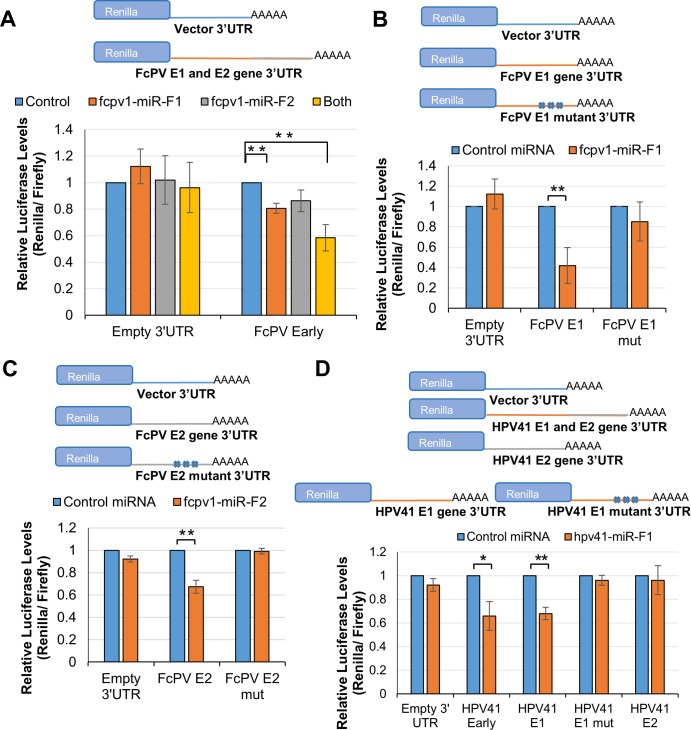
PV-encoded miRNAs can regulate transcript sequences in early genes.RISC reporter assays for the PV-encoded miRNAs. In all panels, the average Renilla luciferase activity normalized to firefly luciferase activity is shown, error bars indicate Standard Error, and asterisks indicate statistical significance, (*) p≤0.05; (**) p≤0.01. (A) HEK293T cells were co-transfected with either a control empty miRNA expression vector (control) or the indicated PV miRNA expression vector along with both the normalization control firefly luciferase vector and a Renilla luciferase-based reporter plasmids with vector UTR (Empty 3’UTR) or FcPV1 genomic DNA containing both putative miRNA docking sites (FcPV1 Early), N = 4. Statistical test performed was a One-Sample t Test. (B) HEK293T cells were co-transfected with either the SV40 miRNA expression vector (Control) or the indicated PV miRNA expression vector and both the control firefly luciferase vector and the Renilla luciferase-based reporter plasmids with vector UTR (Empty), FcPV1 E1 genomic sequence (E1), or the seed sequence mutant (E1 mut), N = 4. Statistical test performed was a One-Sample t Test. (C) HEK293T cells were co-transfected with either the SV40 miRNA expression vector (Control) or the indicated PV miRNA expression vector and both the control firefly luciferase vector and the Renilla luciferase-based reporter plasmids with vector UTR (Empty), FcPV1 E2 genomic sequence (E2), or the seed sequence mutant (E2 mut), N = 12. Statistical test performed was a One-Sample t Test. (D) HEK293T cells were co-transfected with either the SV40 miRNA expression vector (Control) or the HPV41 miRNA expression vector and both the control firefly luciferase vector and the Renilla luciferase-based reporter plasmids with vector UTR (Empty), HPV41 genomic DNA containing both putative miRNA sites (HPV41 Early), the site in E1 (HPV41 E1), the seed sequence mutant (E1 mut) N = 7 or the site in E2 (HPV41 E2), N = 4. Statistical test performed was a One-Sample t Test.